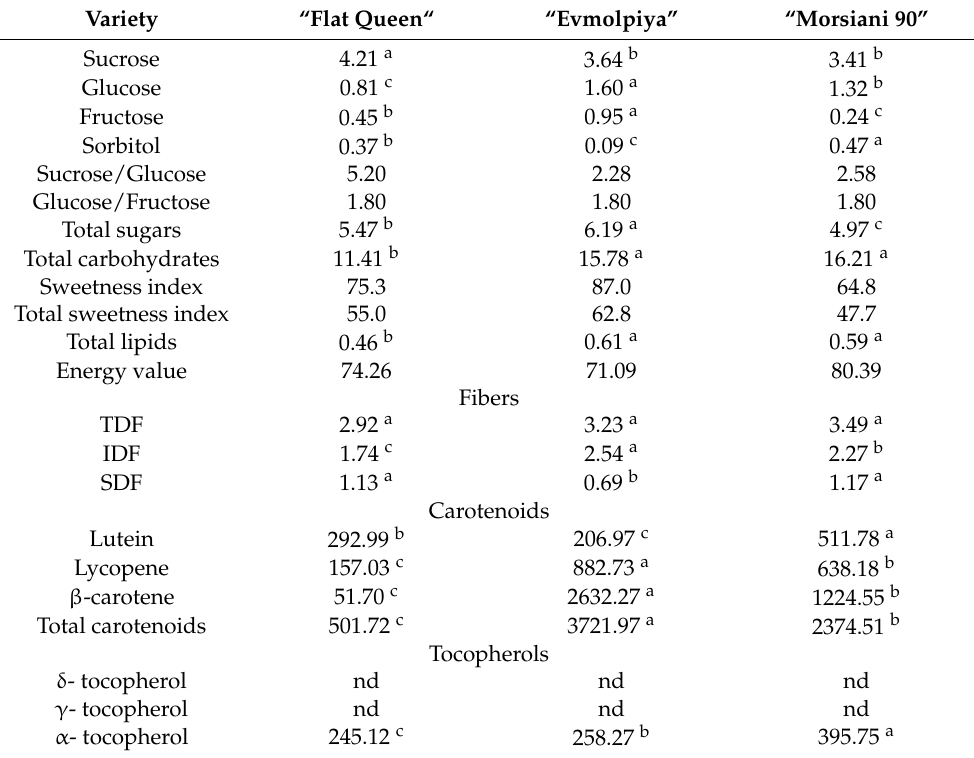
nd—not detected. Values are means, n = 3 per treatment group. Means in a row without a common superscript letter (a–c) differ ( p < 0.05) as analyzed by one-way ANOVA and the TUKEY